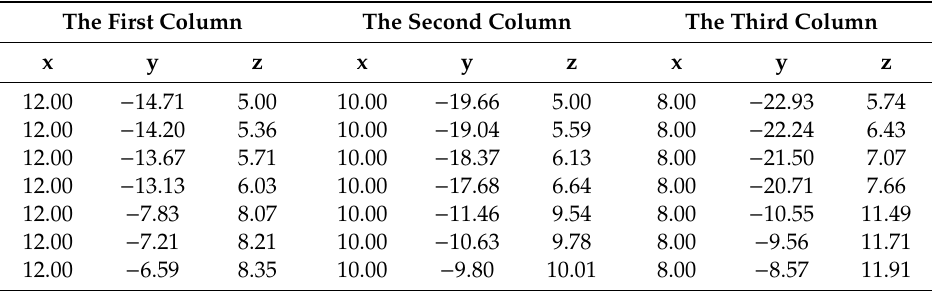
Table 1. The curved surface data on the